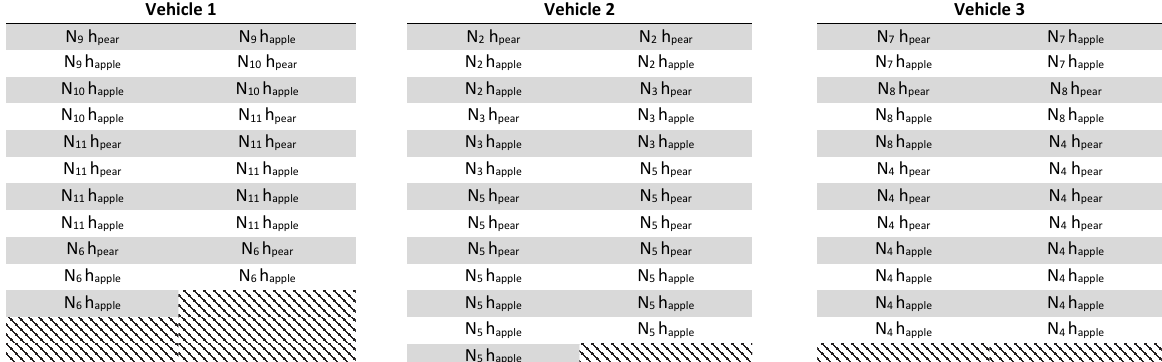
Solutions of the